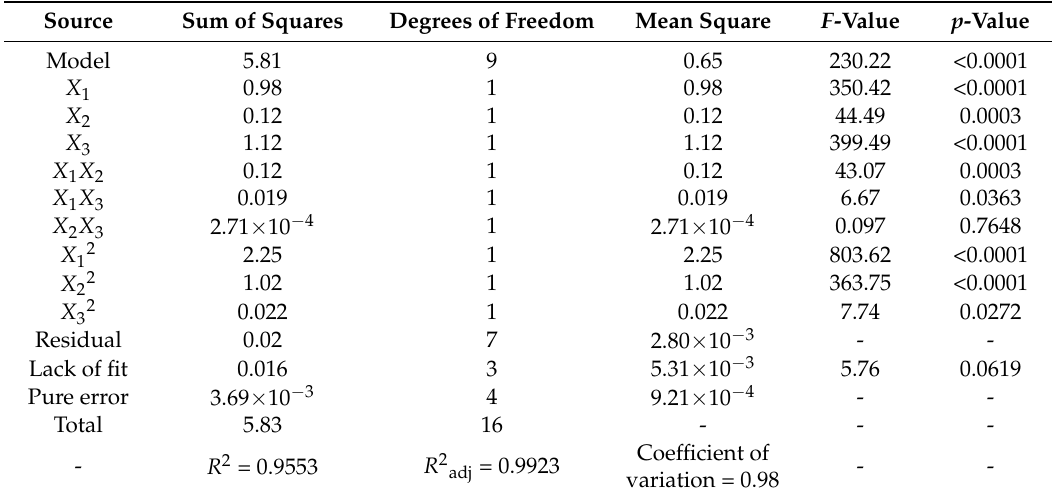
Table 2. Analysis of variance (ANOVA) of the quadratic model and lack of